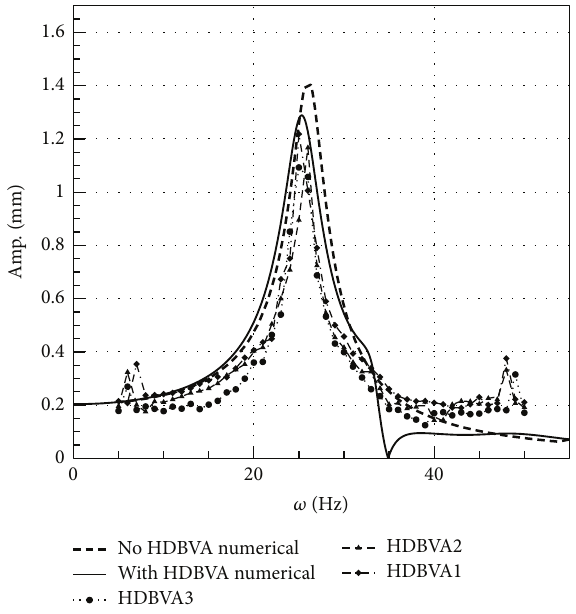
Figure 27: Frequency response of 𝑍 𝑍 DOF of case Figure 10(d), HDBVAs start at the near-force